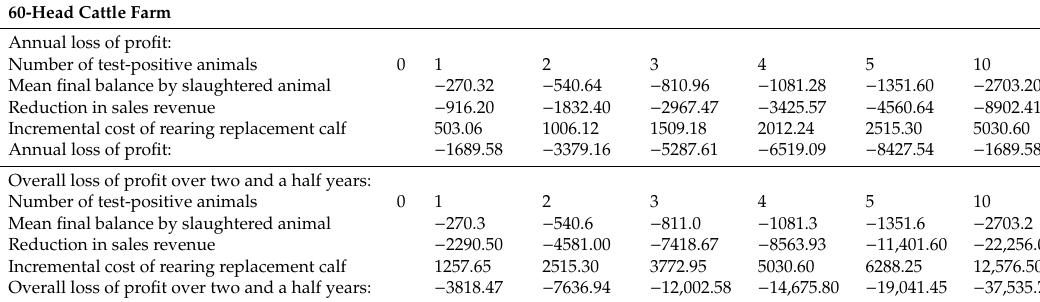
Table 10. Loss of profit on a farm with 60 head of